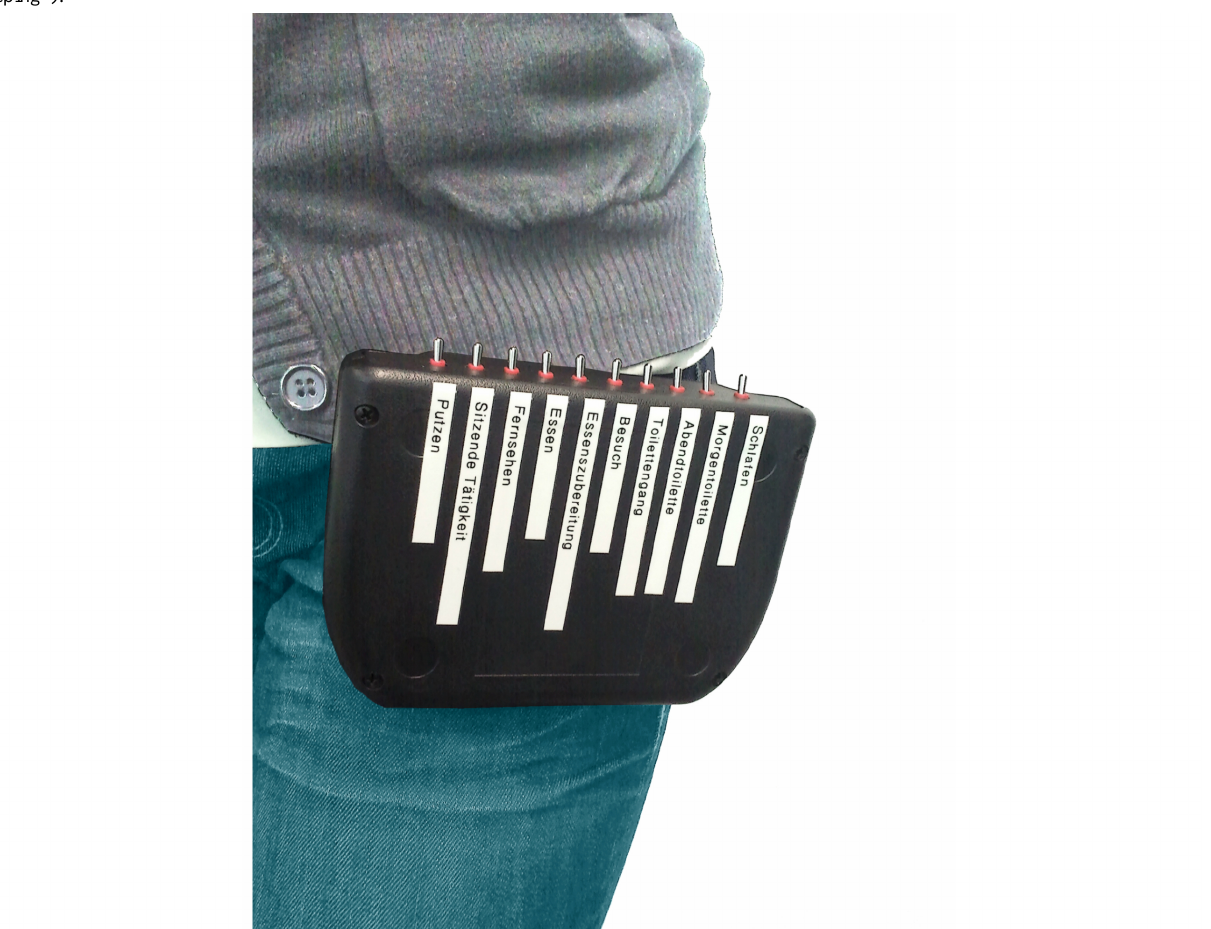
Figure 3. Wireless protocol device worn by participant (switches on top of the box are labeled with 8 different activities such as "watching TV" or